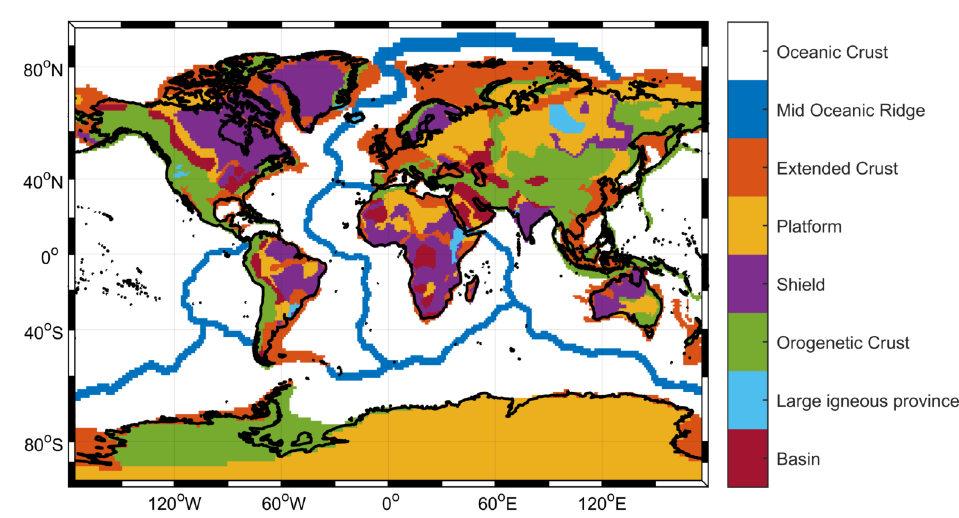
Figure 4. Map of geological provinces used to simulate the observed gravity signal.